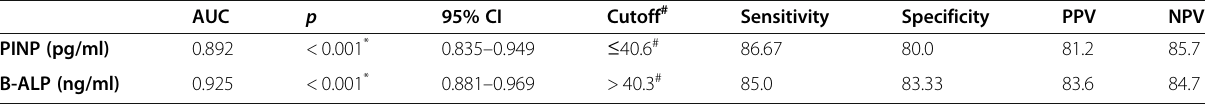
Table 5 Agreement (sensitivity, specificity) for PINP and B-ALP to discriminate osteoporosis patients ( n = 60) from healthy control (